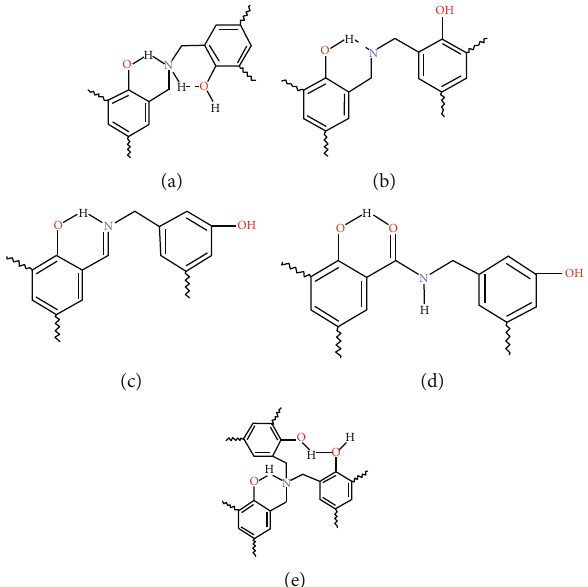
Figure 6: Structural intermediate in the cross-linking process.